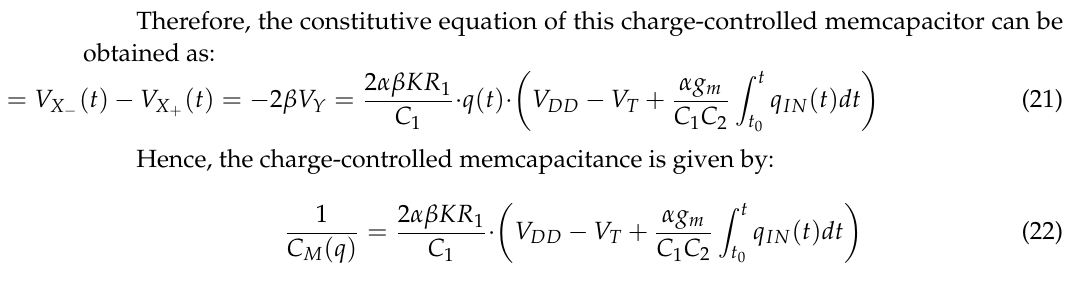
Figure 8. Memcapacitor emulator circuit proposed by Vista and Ranjan [48] based on a DXCCDITA.